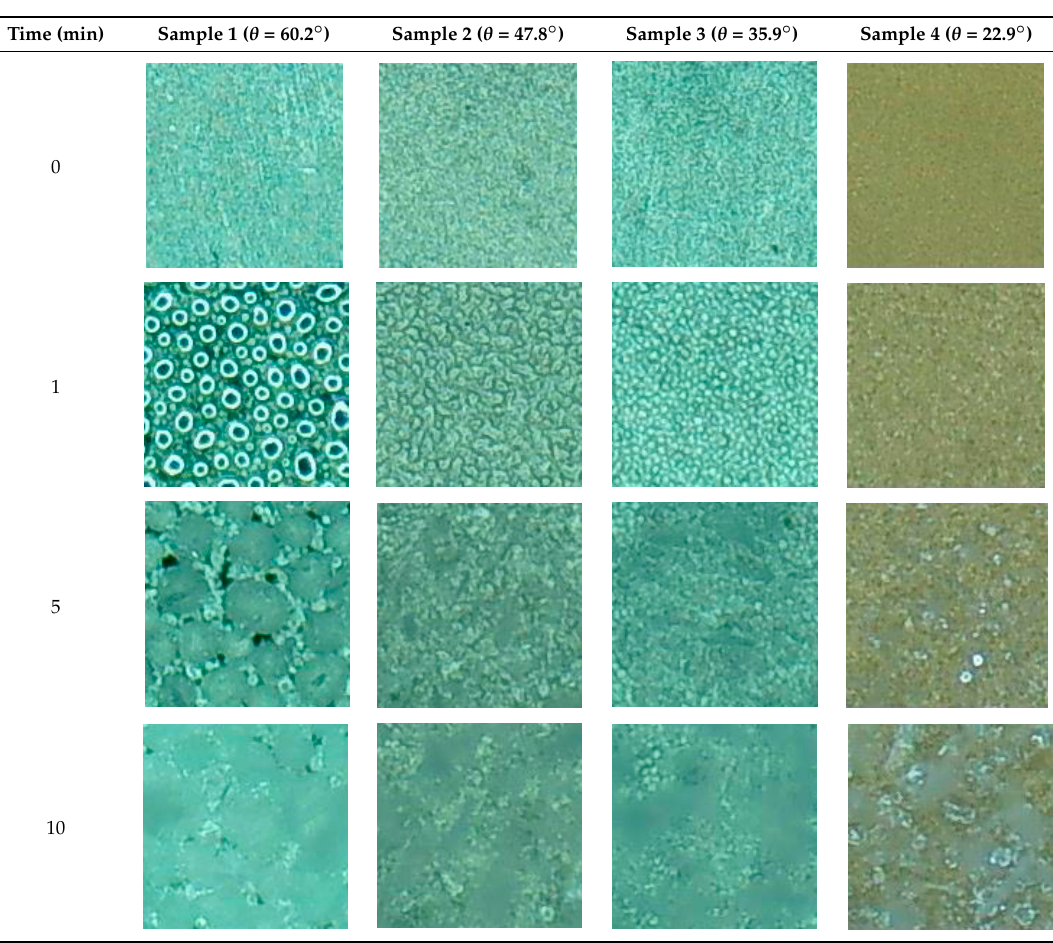
Table 4. The structure of the frost layer on different aluminum surfaces at T s = − 15 ◦ C, T a = 5 ◦ C, and ϕ = 60%.